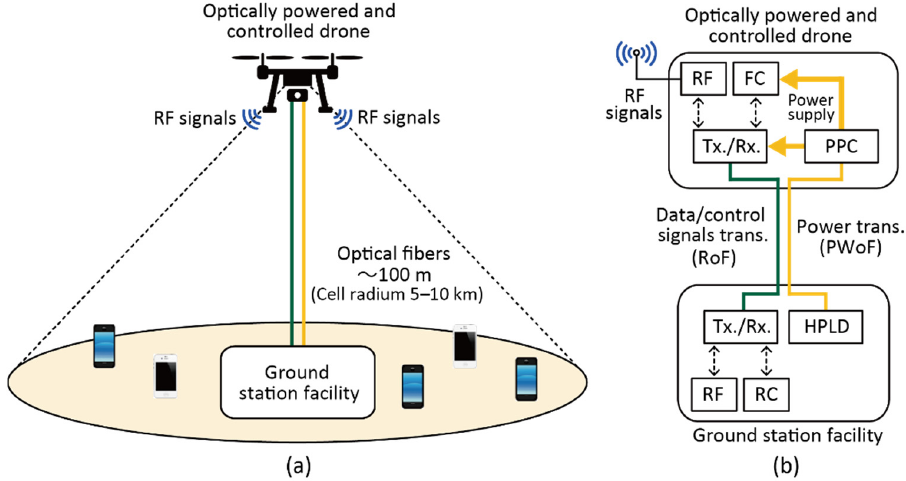
Figure 1. ( a ) Schematic view and ( b ) configuration of optically powered drone using optical fibers for airborne base stations. FC: flight controller, PPC: photovoltaic power converter, RC: remote controller, HPLD: high-power laser diode.